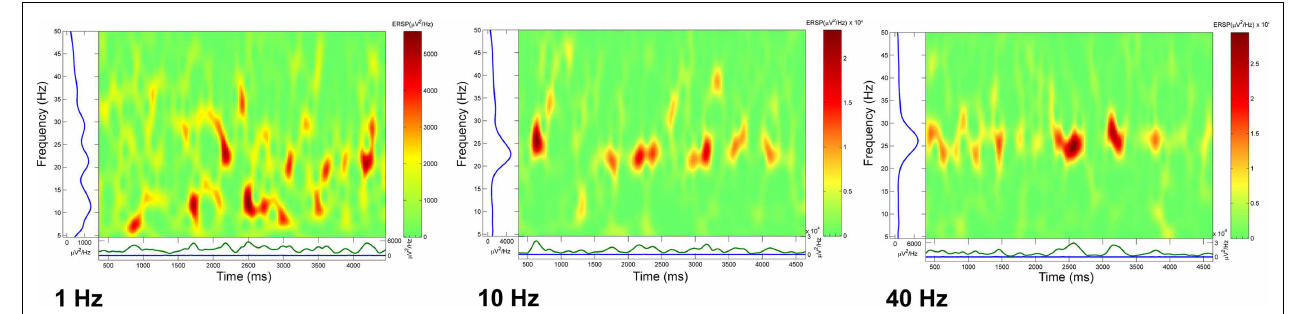
of four pulses.The train of four stimuli was delivered at 1 (left ERSP), 10 (middle ERSP), and 40Hz (right ERSP). Note the increasing coherence as stimulation frequency increased until high amplitude bursts of activity were induced for 4–5s following the stimulus.These studies suggest that the natural frequency for inducing maximal coherence was in the gamma band range